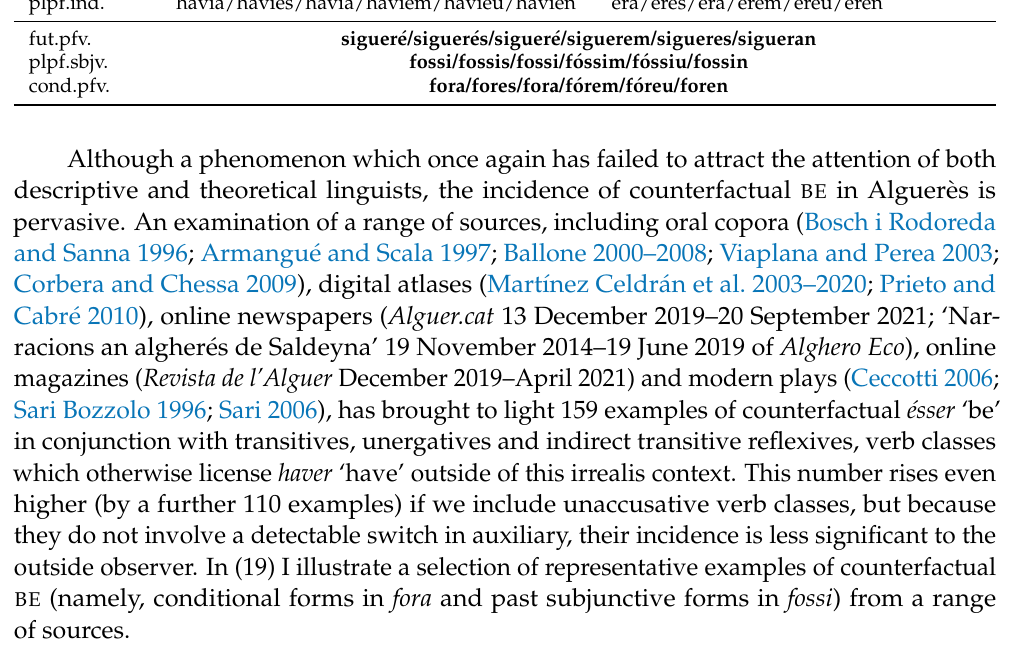
Table 1. Alguer è s active compound paradigms of admitir ‘admit’ and anar ‘go’ 13 . admitit ‘admitted’ anat(s)/-da/-des ‘gone. MSG ( PL )/ FSG / FPL ’ prs.pfv.ind. he/has/ha/havem/haveu/han s ó /s é s/ é s/sem/s é u/s ó nt prs.pfv.sbjv. hagi/hagis/hagi/h à gim/h à giu/hagin sigui/siguis/sigui/siguem/sigueu/siguin plpf.ind. havia/havies/havia/hav í em/hav í eu/havien era/eres/era/ é rem/ é reu/eren